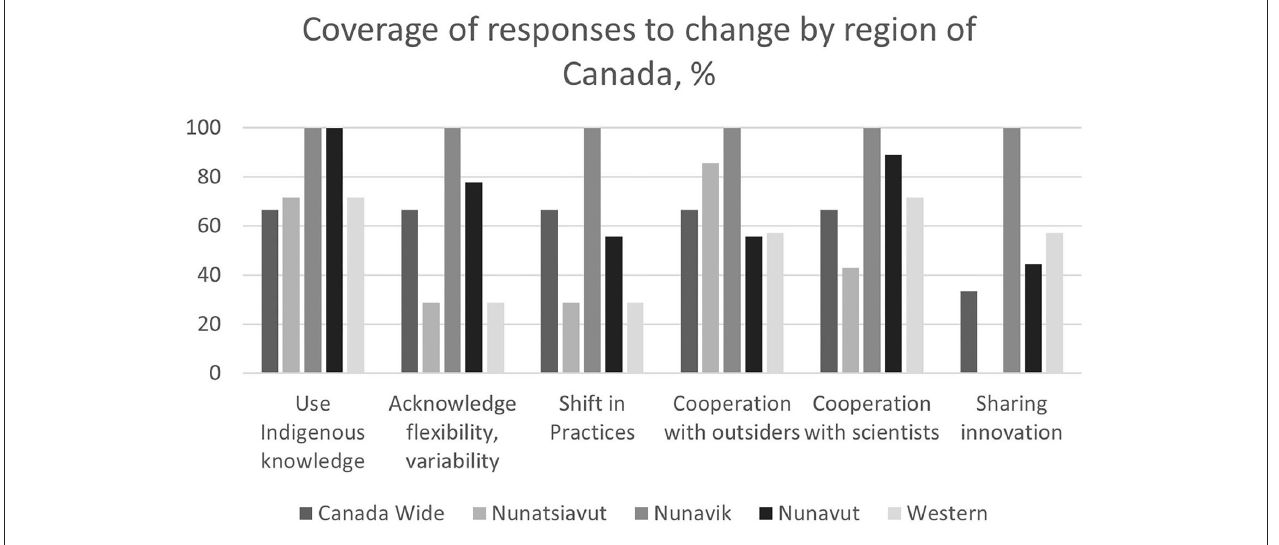
FIGURE 7 | Coverage of responses to change by region of Canada, % of total